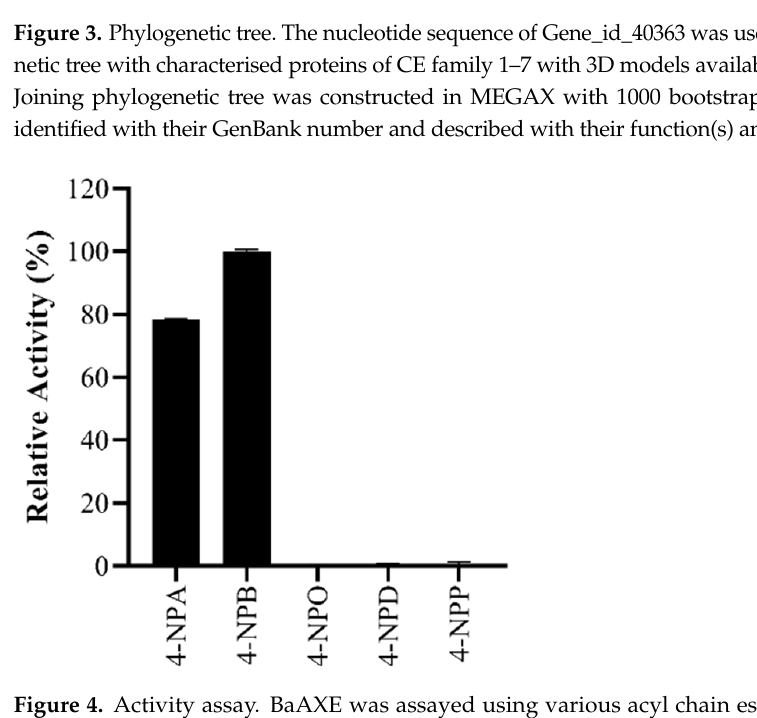
Figure 4. Activity assay. BaAXE was assayed using various acyl chain esters (C2–C16). 4-NPA—4- nitrophenyl acetate; 4-NPB—4-nitrophenyl butyrate; 4-NPO—4-nitrophenyl octanoate; 4-NPD—4- nitrophenyl decanoate; 4-NPP—4-nitrophenyl palmitate. The assay reaction was carried out with a 1 mM concentration of each substrate, and the reaction proceeded for 20 min at 40 °C. Absorbance readings were taken at 410 nm at 1 min intervals. Each bar represents activity on each substrate, n = 3 and the error bar corresponds to the standard error of the mean (SEM).